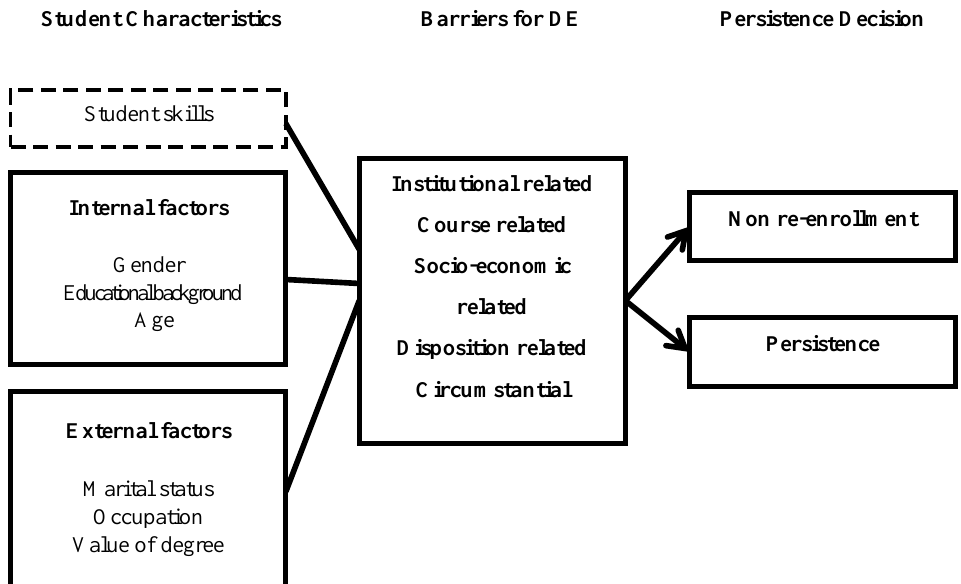
Figure 1. Framework of study into DE persistence and dropout at